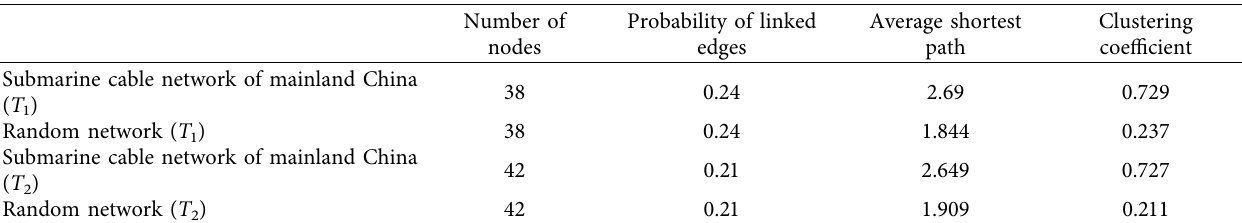
Figure 2: Connection of submarine cable network of mainland Table 2: Comparison of submarine cable network of mainland China and same-size random network metrics.